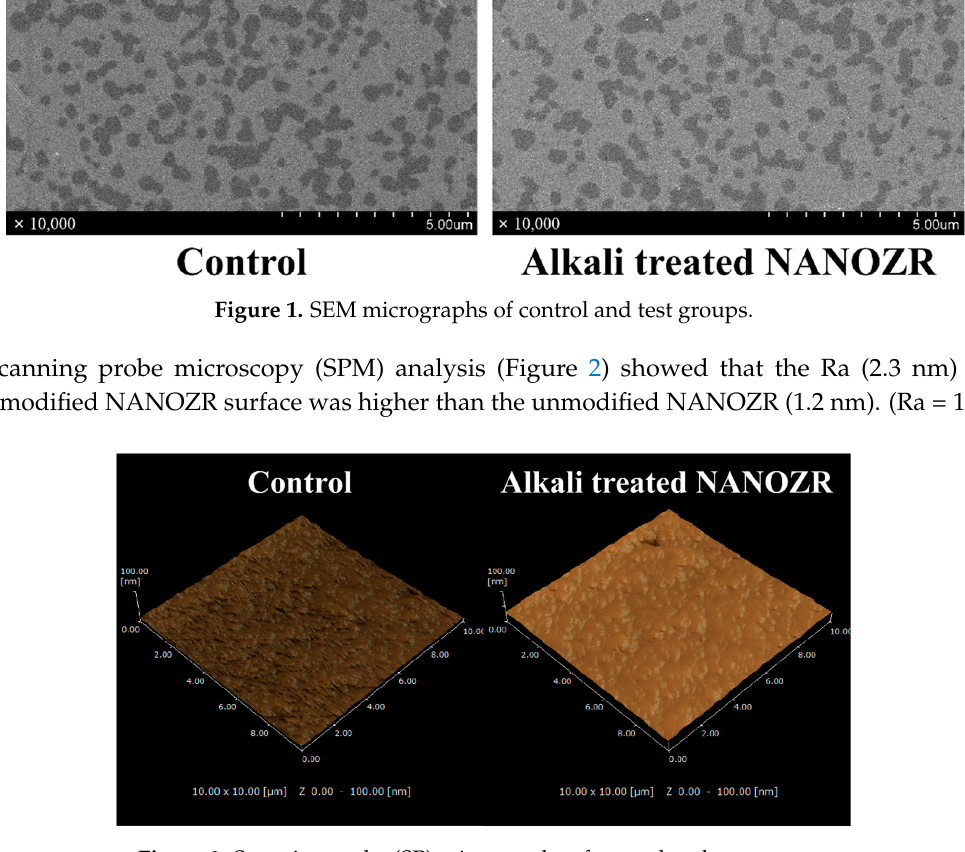
Figure 2. Scanning probe (SP) micrographs of control and test groups.